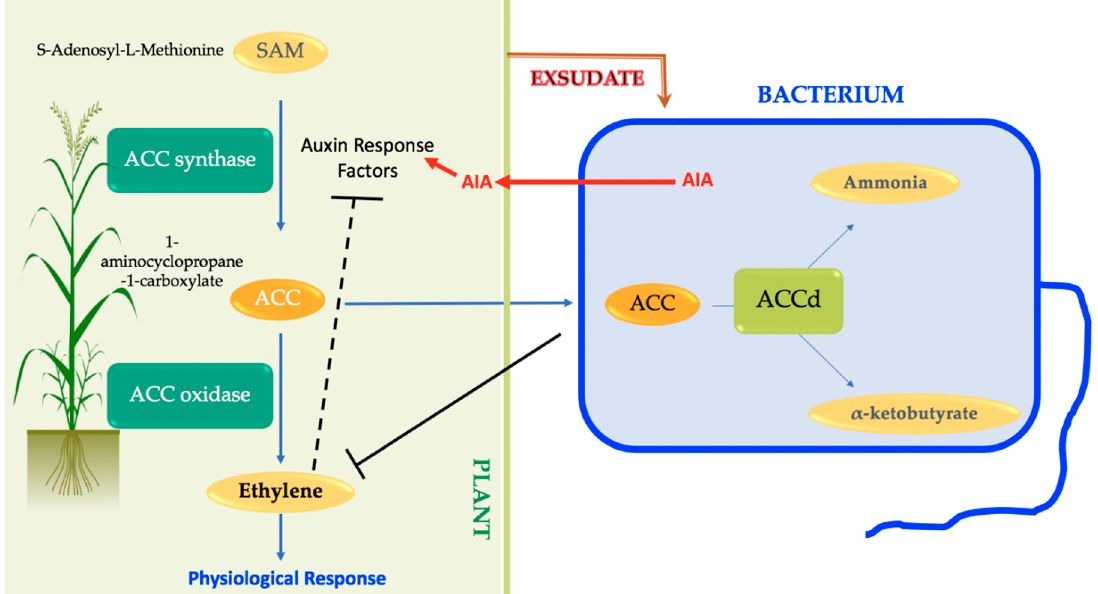
Figure 5. Model for how the ACC deaminase lowering of ethylene levels modulate physiological response.